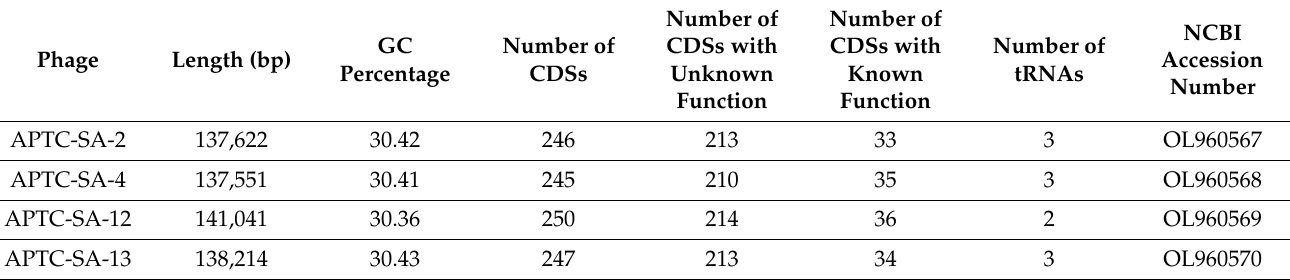
Table 2. Predicted functional ORFs of Staphylococcus